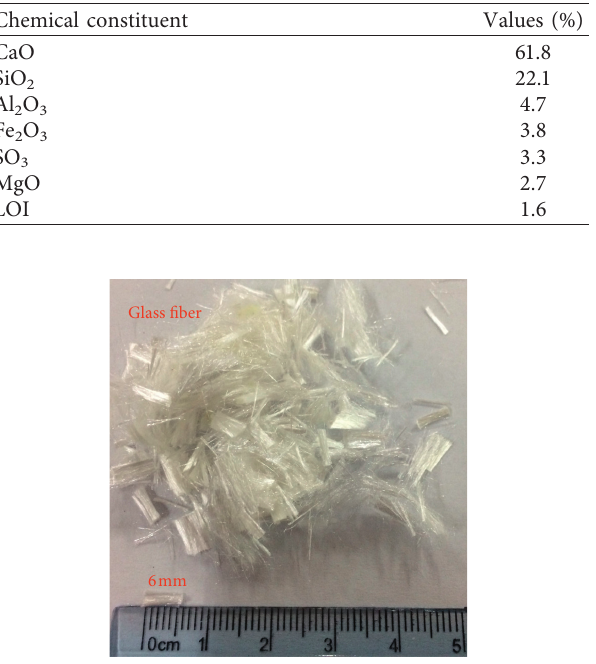
Figure 4: Photograph showing the discrete glass fibers. Table 3: Index of the glass